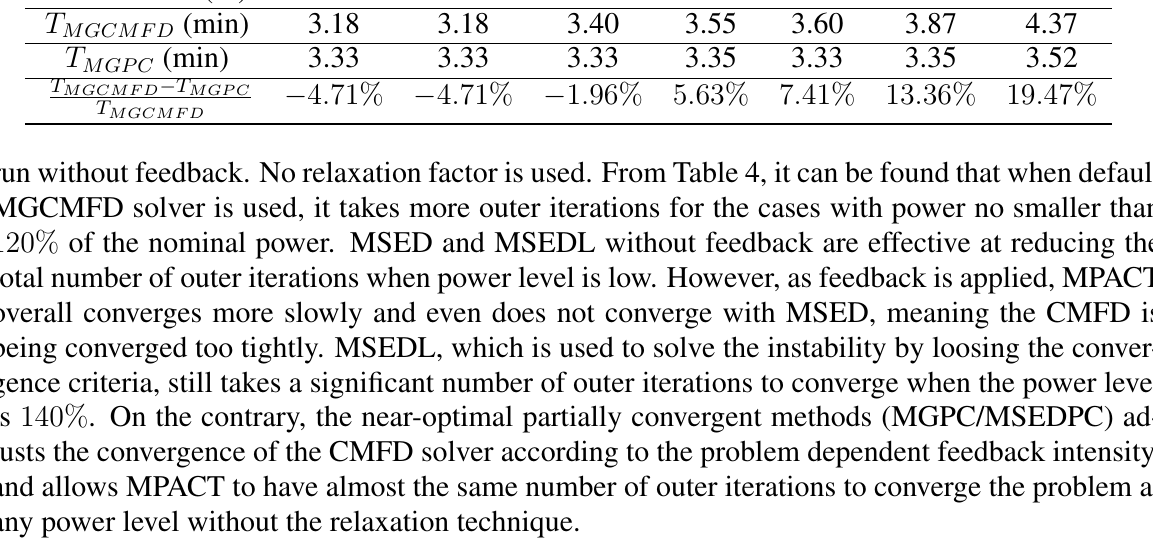
Table 3: Total Number of Outer Iterations for Problem 6–Single